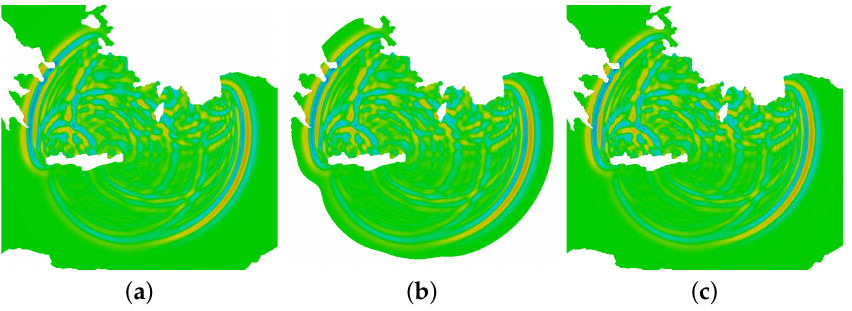
Figure 10. The solution at t = 3000 s, with the full method at the left panel ( a ), the domain adaptive method at the center panel ( b ) and the FreeFem++ adaptation with err = 10 − 7 at the right panel ( c ) (min = − 5.5 × 10 − 2 m, max = 4.7 × 10 − 2 m, for the three